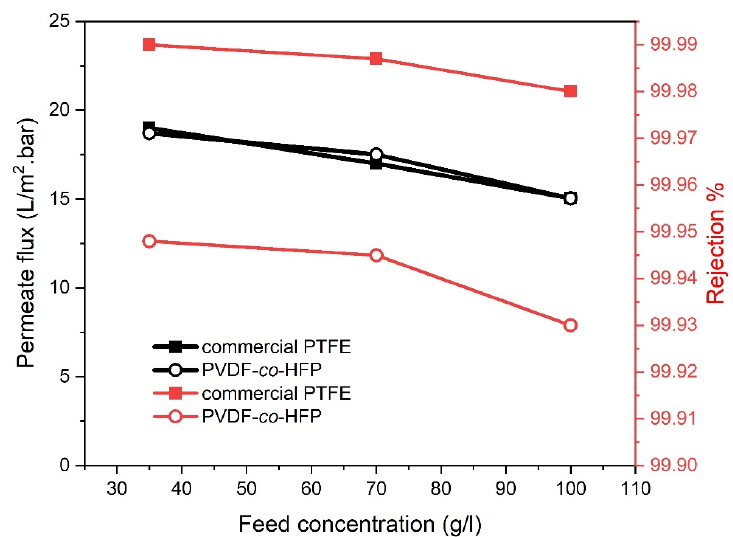
Figure 6. Effect of feed concentration on permeate flux and salt rejection at 65 °C feed temperature, 0.6 feed flowrate and 300 L / h sweep gas flow rate for PTFE and PVDF-co-HFP 0.6 feed flowrate and 300 L/h sweep gas flow rate for PTFE and PVDF-co-HFP membranes.